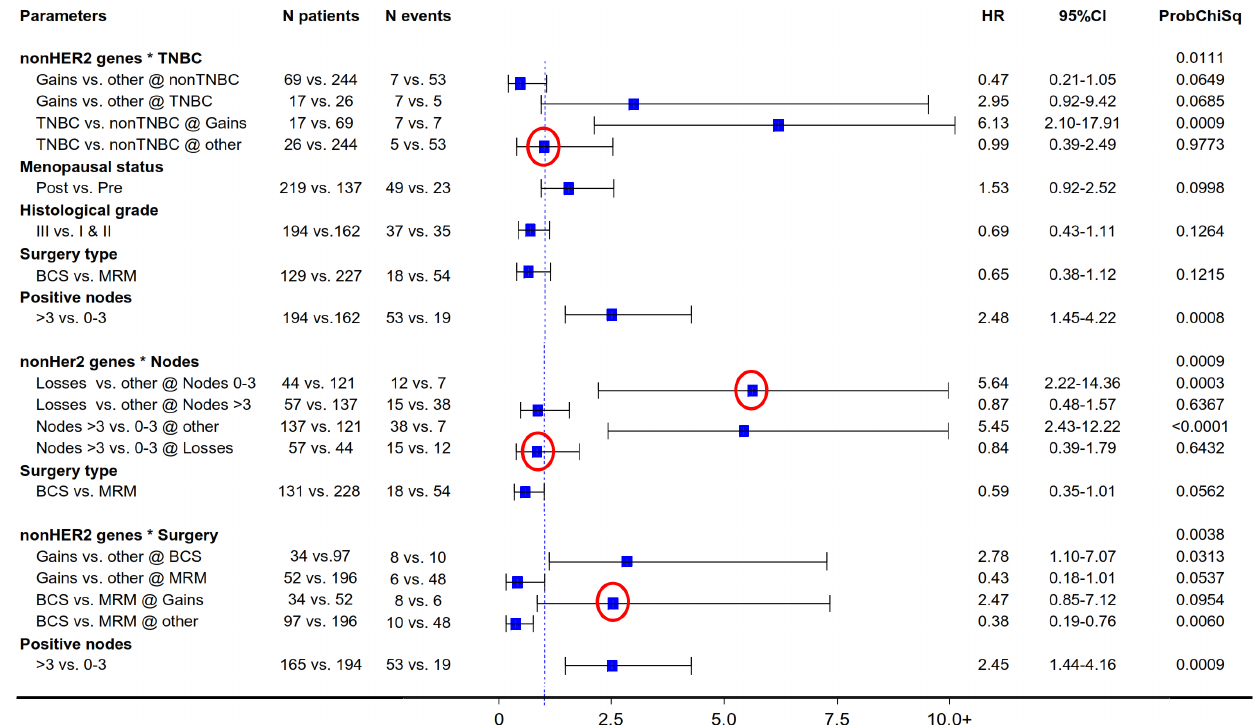
Figure 7. Multivariate analysis models involving the main significant non-HER2-gene CN pattern effects on patient OS. Findings as for DFS in Figure 6.